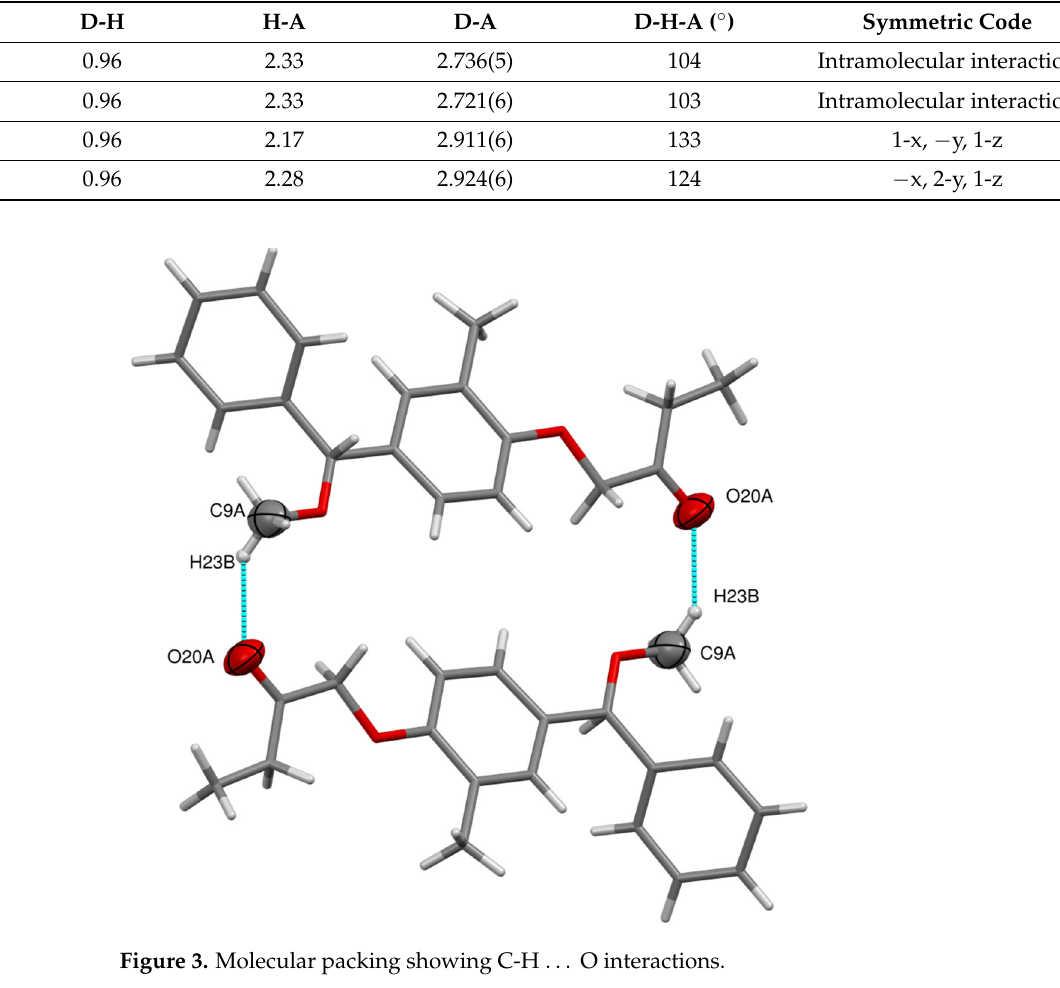
Table 2. Hydrogen bond geometry(Å).